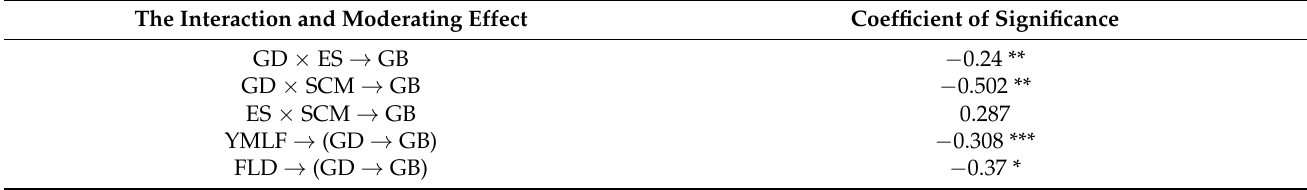
Table 3. The interaction effect on behavioral intention between consciousnesses and the moderating effect of external context variables on the relationship between consciousness and